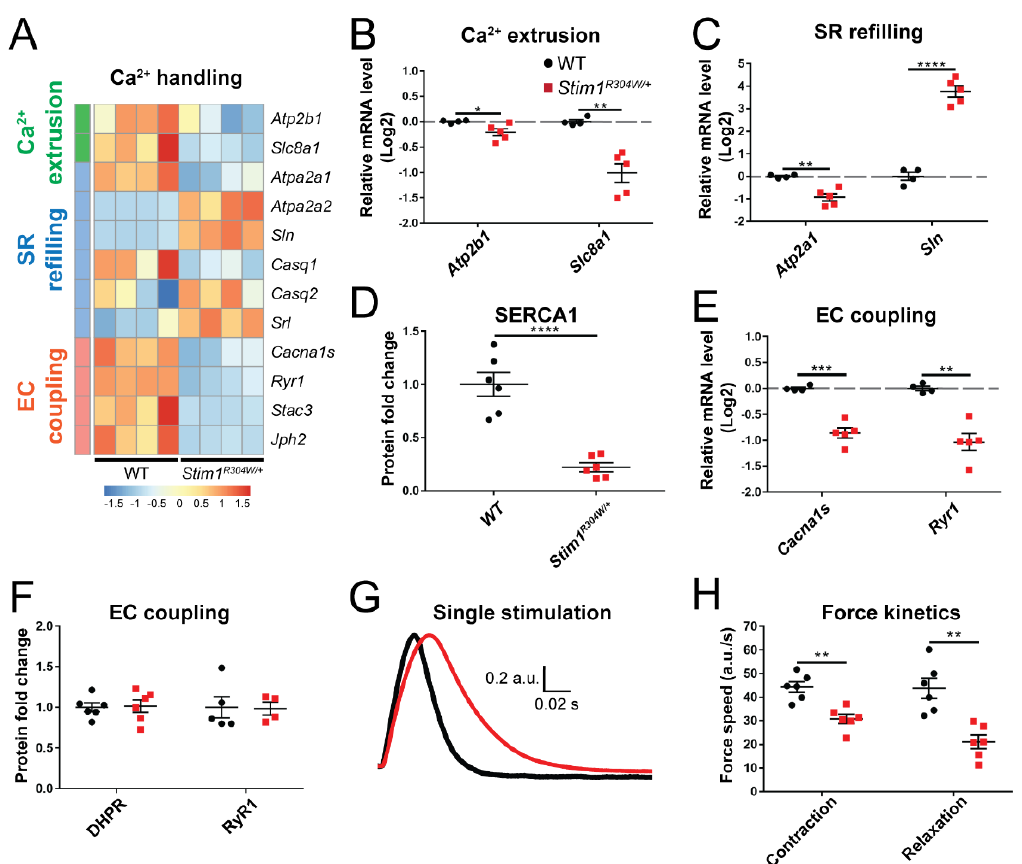
Figure 2. Altered expression of Ca 2+ handling genes in Stim1 R304W/+ muscle and abnormal contraction and relaxation properties. ( A ) RNAseq heatmap illustrating the relative expression of genes implicated in Ca 2+ extrusion, sarcoplasmic reticulum (SR) refilling, and excitation-contraction (EC) coupling in Stim1 R304W/+ and wild-type (WT) tibialis anterior ( n = 4). ( B ) RT-qPCR showing reduced expression of Atp2b1 (encoding a plasma membrane Ca 2+ pump) and Slc8a1 (plasma membrane Na + /Ca 2+ exchanger) in Stim1 R304W/+ mice ( n = 4–5). ( C , D ) SERCA1 gene expression and protein levels are reduced in Stim1 R304W/+ mice, while Sln expression is increased ( n = 4–6). ( E , F ) Downregulation of Cacna1s and Ryr1 in Stim1 R304W/+ tibialis anterior, but normal DHPR and RyR1 protein levels ( n = 4–6). ( G , H ) Mean normalized force production following a single 1 Hz stimulation showing delayed muscle contraction and relaxation speed in Stim1 R304W/+ mice ( n = 6). Significant differences are illustrated as * ( p < 0.05), ** ( p < 0.01), *** ( p < 0.001), and **** ( p <